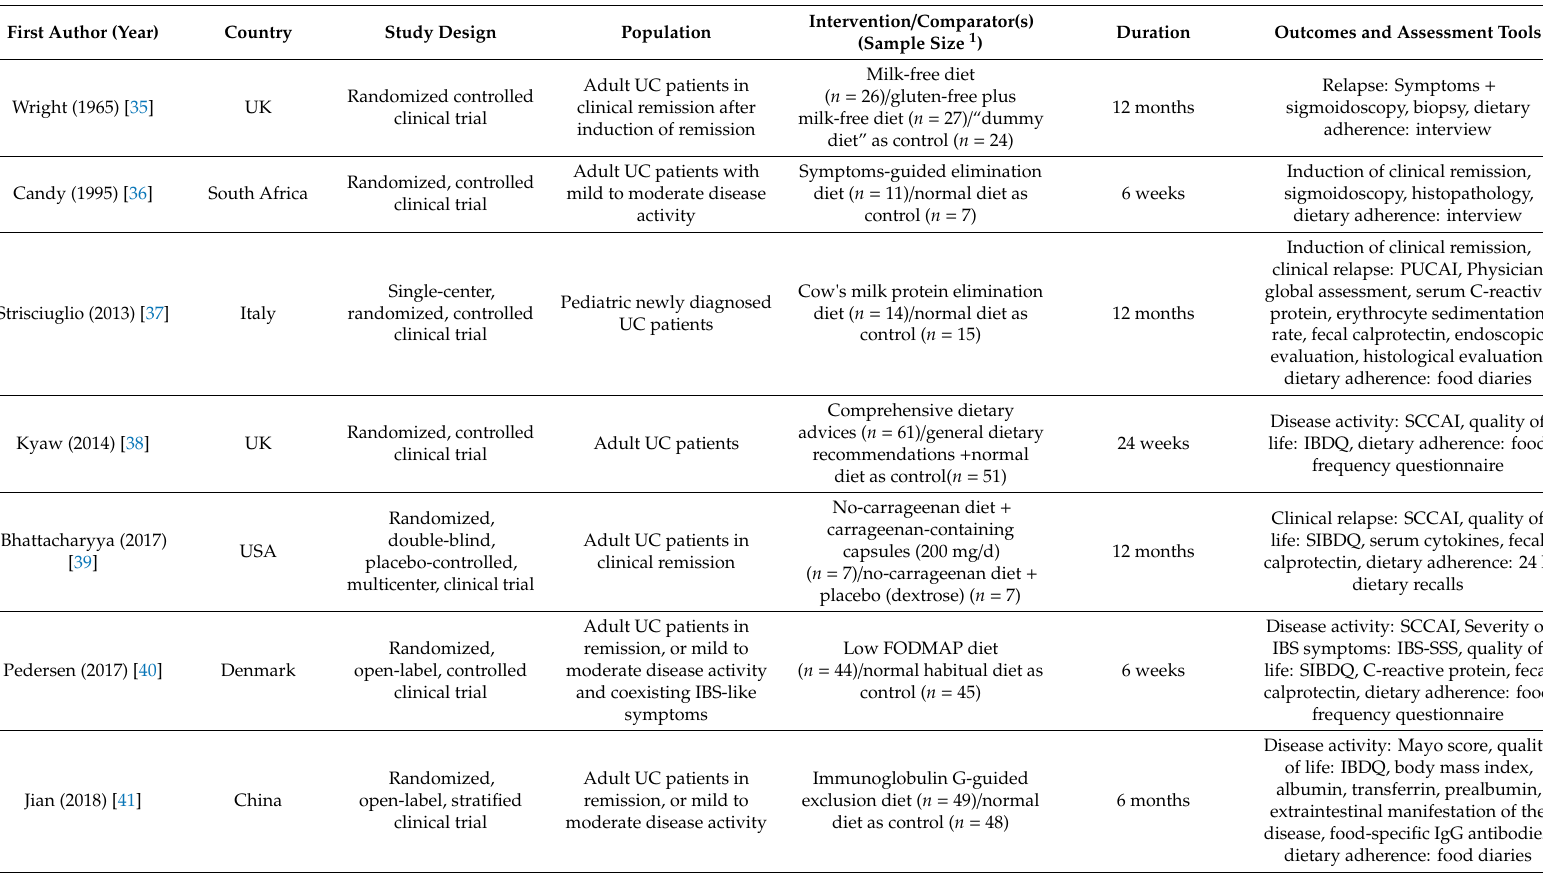
Table 1. General characteristics of studies examining the role of diet for maintenance of remission in ulcerative colitis